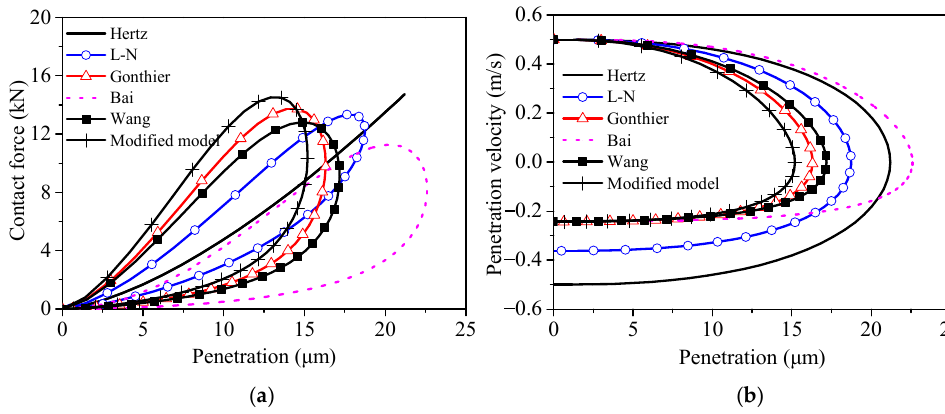
Figure 3. Dynamic responses based on the six models: ( a ) contact force; ( b ) penetration velocity. Table 1. Parameters of the bearing and the journal.